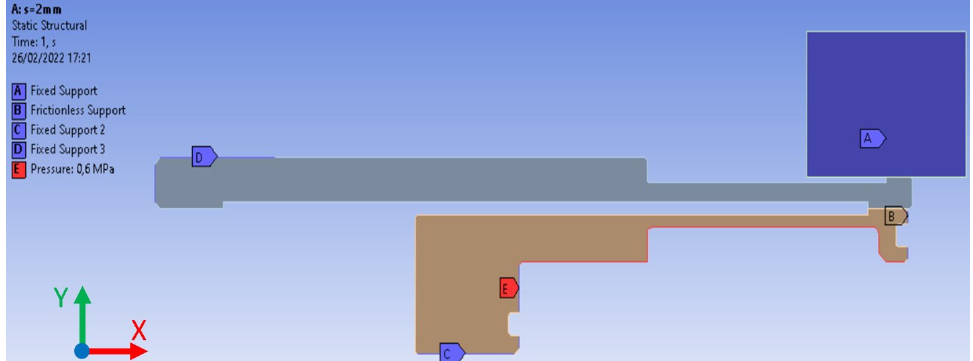
Figure 3. Axisymmetric finite element model of the clamping